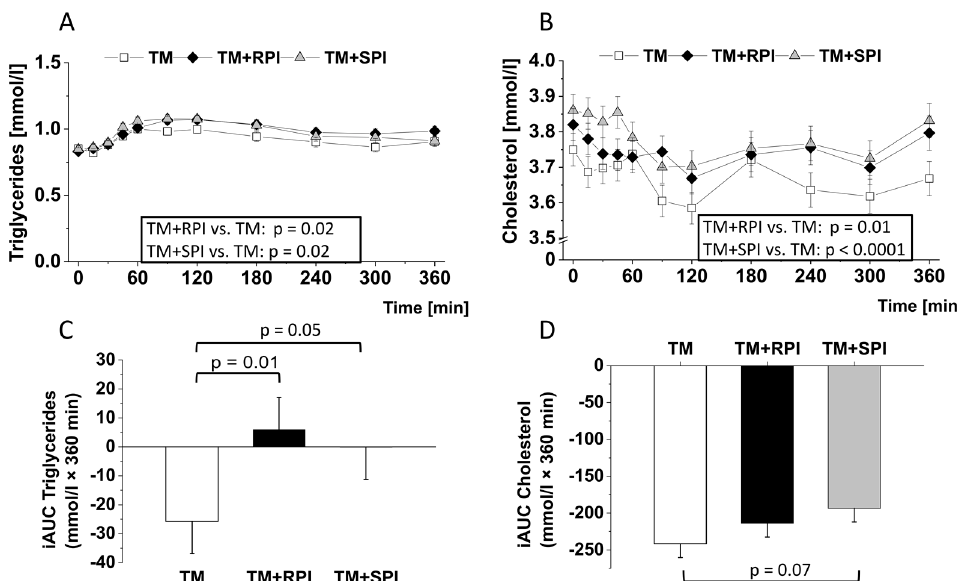
Figure 4. Postprandial response to the test meal (TM) with either no additional protein as reference ( □ ), 28 g rapeseed protein isolate (RPI) ( ♦ ), or 28 g soy protein isolate (SPI) ( ▲ ) with regard to plasma levels of triglycerides ( A ) and cholesterol ( B ) and the incremental area under the curve (iAUC) of triglycerides ( C ) and cholesterol ( D ). Differences in postprandial glucose and insulin concentrations after the ingestion of the three test meals over 6 h were evaluated with a mixed model to test the effects of treatment, time, and their interaction (treatment × time). The value at baseline (before treatment) was considered a covariate. The iAUCs were calculated for each subject and treatment using the trapezoidal rule. The mixed-models procedure (PROC MIXED) was used for all traits. For iAUC treatment, the sex, sequence, and period were set as fixed effects, and subjects were included as random effects. All p values were adjusted according to the Tukey–Kramer multiple group comparison procedure. For time-point analysis, the paired t-test was applied. Significance was accepted as p < 0.05. Data are presented as LSMs ± SEs ( n = 19).